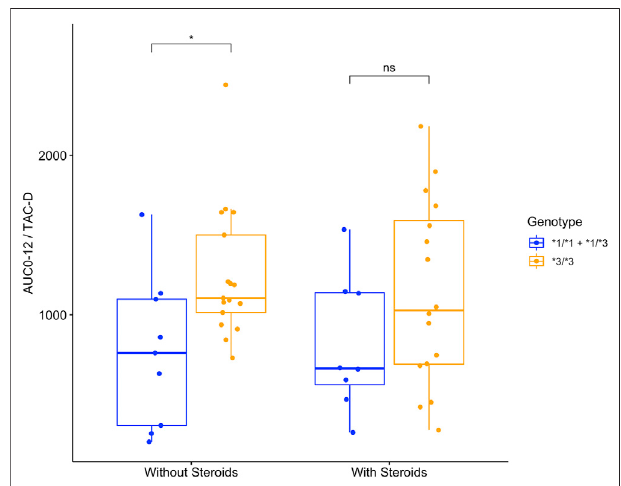
FIGURE 2 | Area under the curve in 12 h normalized by dose requirements (AUC 0-12h /TAC-D ng*hr/ml/mg/kg) in 52 patients with different CYP3A5 genotypes with or without steroids from day 7 post-transplantation